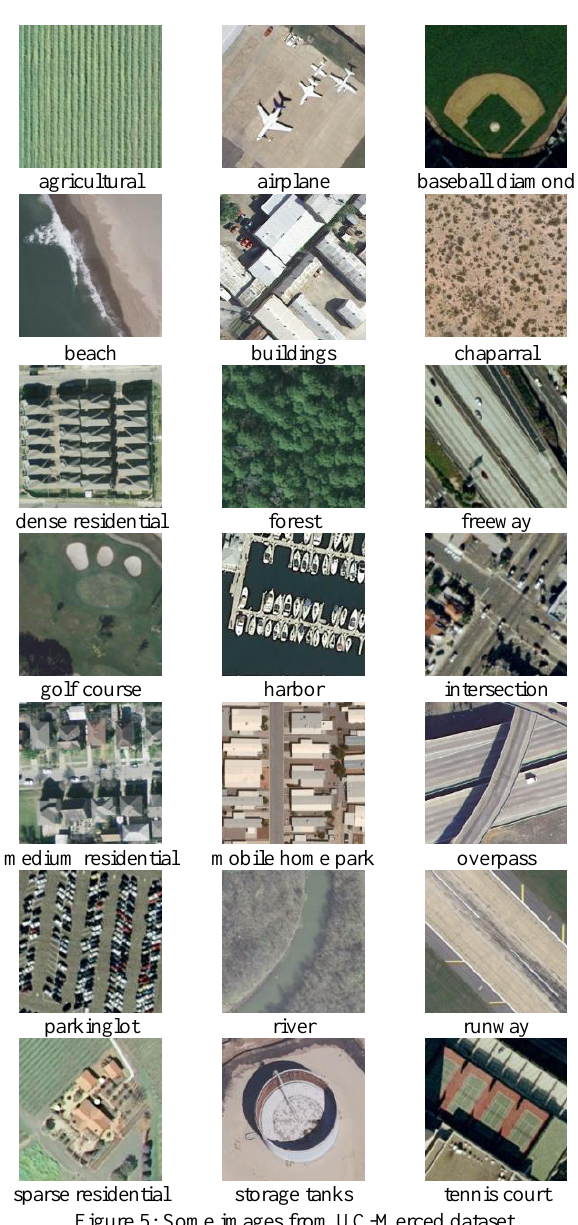
Figure 5: Some images from UC-Merced dataset Another dataset is NWPU-RESISC45 dataset (Cheng et al.